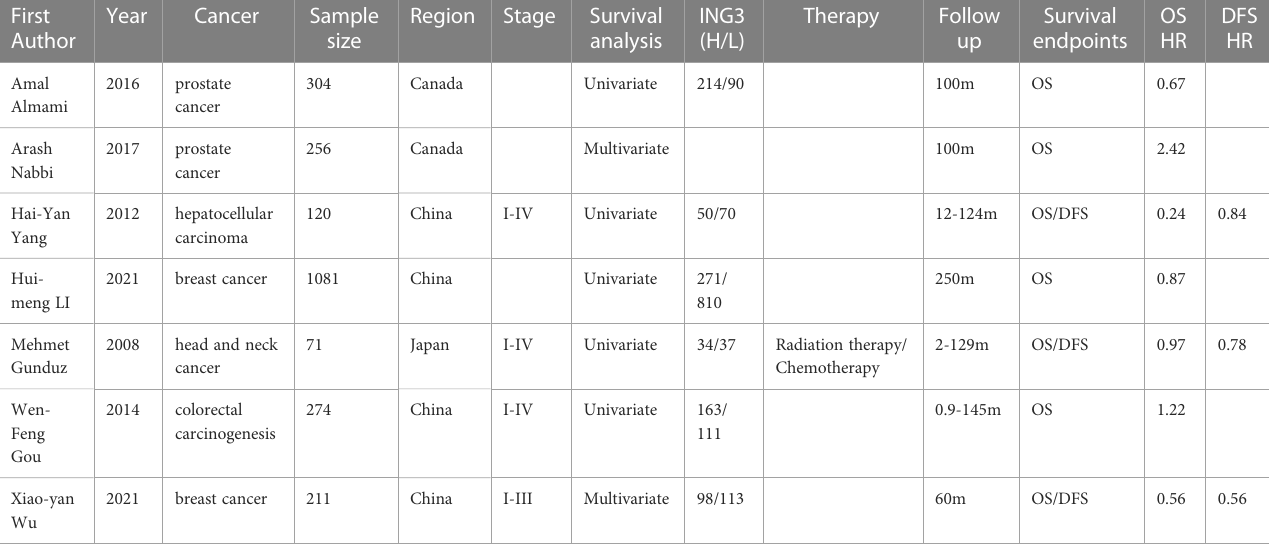
TABLE 1 Study characteristics of the studies included in the systematic review and